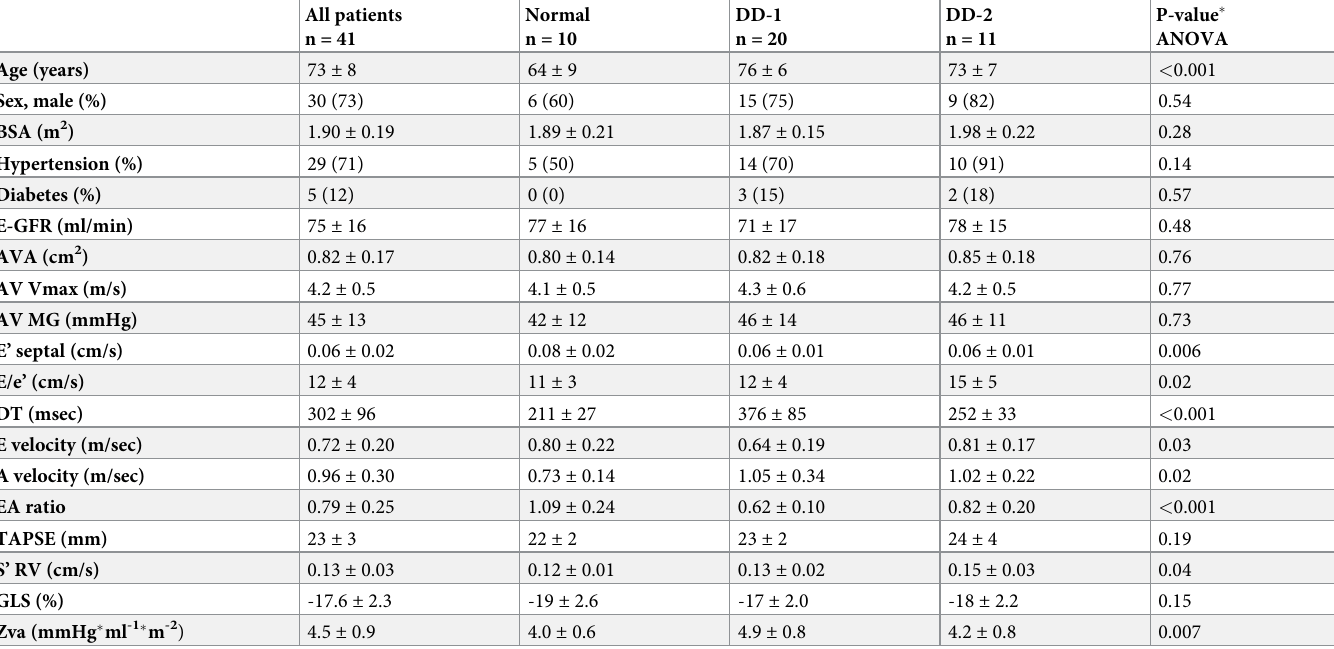
Table 1. Demographic data and selected echocardiographic parameters according to LV diastolic